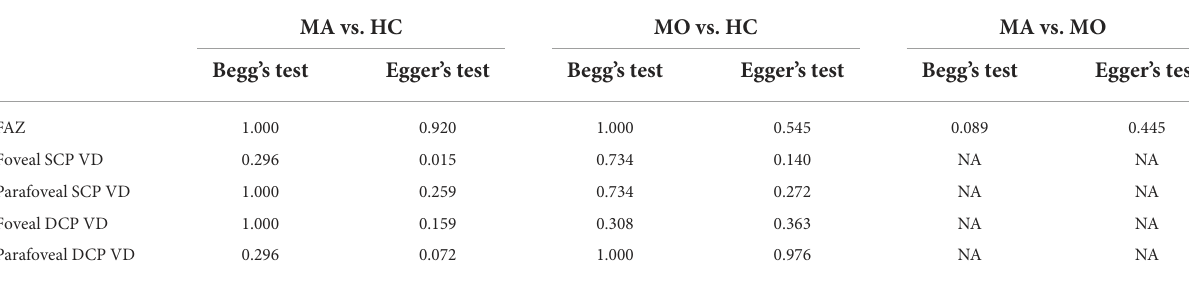
TABLE 2 Publication bias measured by Begg’s test and Egger’s